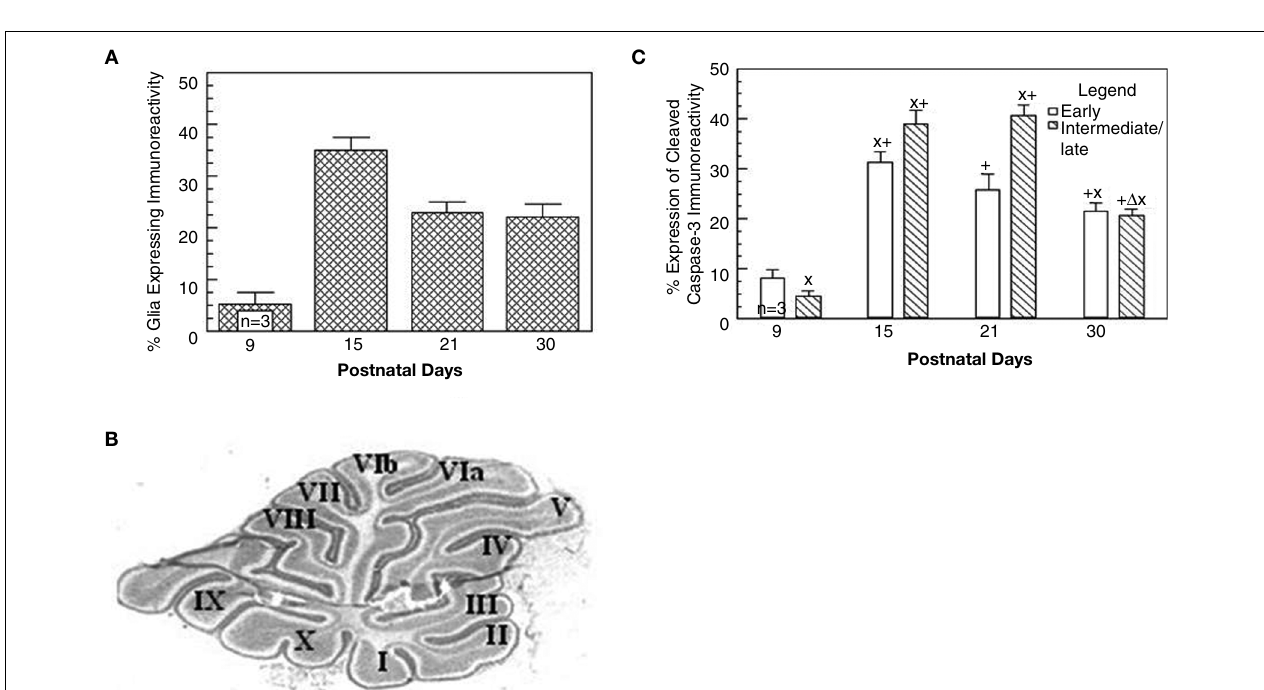
(visualized with Alexa 488 (green) and Alexa 546 (red), respectively). In Panel (E) cells are double labeled with S-100b (red fl uorescence) and Glast (green fl uorescence), two markers of Bergmann glia, respectively, to further verify the presence of caspase-3 in the nuclei of Bergmann glia surrounding Purkinje neurons obtained from 15-day-old cerebellum. Panel (F) is a modifi ed image of an original cleaved caspase-3 labeling visualized with green wavelength using a Alexa 488 fl uorescent dye coupled with an auto-fl uorescent label of the tissue at the red wavelength (594 nm), showing the location of immunoreactive cells within the Purkinje cell layer in a 21-day-old cerebellum. P – Purkinje cell; B – Bergmann glia; ML – molecular layer.